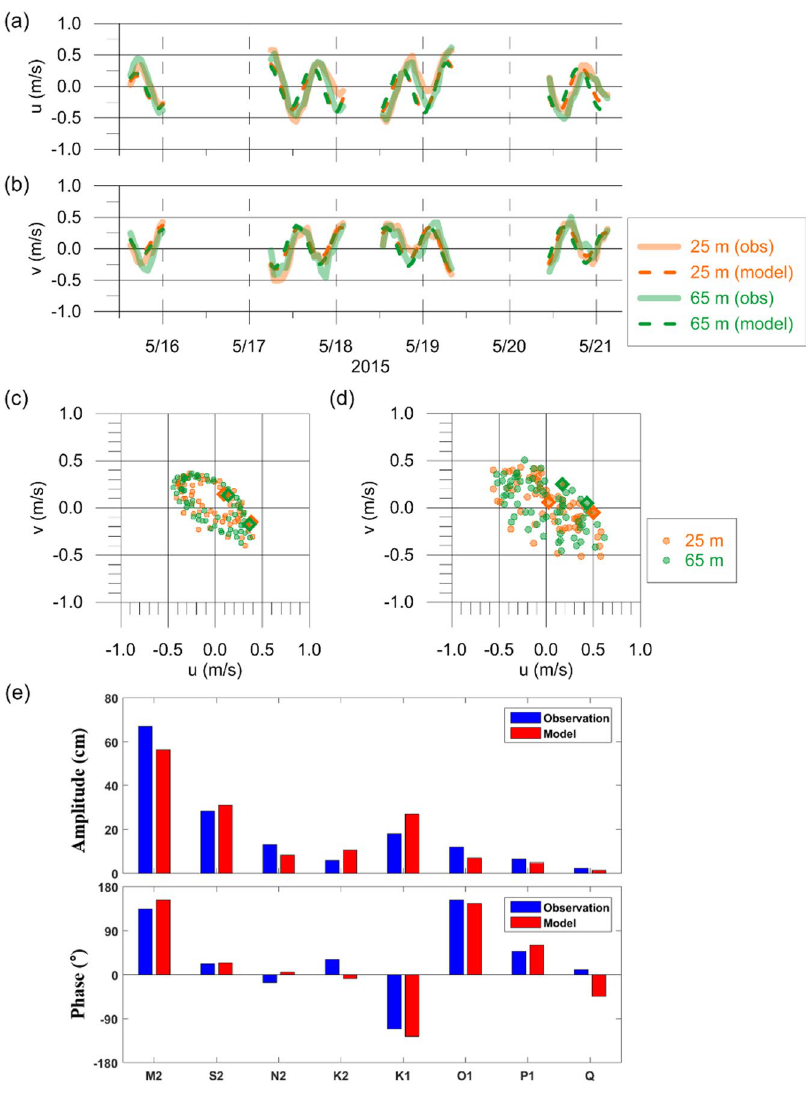
Figure 2. Time series of ( a ) zonal and ( b ) meridional components and ( c , d ) hodographs of absolute (mostly tidal) horizontal current vectors at the upper (25 m, orange) and lower (65 m, green) depths in the SAVEX-15 area (water depth: 100 m), ~50 km east of the IORS in May 2015. Time series of ( a ) zonal and ( b ) meridional components and ( c , d ) hodographs of absolute (tidal plus subtidal) horizontal current vectors at the upper (25 m, orange) and lower (65 m, green) depths in the SAVEX-15 area (water depth: 100 m), ~50 km east of the IORS in May 2015. In ( a ) and ( b ), each component observed during the SAVEX-15 cruise (thick solid line) and reproduced by the ROMS (dashed line) are superimposed. The reproduced and observed horizontal current vectors are shown by circles with an interval of one hour in ( c ) and ( d ), respectively. Open diamond symbols denote a time difference of 48.00 hours to compare the relative phase of tidal currents over the period shown in ( a ) and ( b ). The model data during the observational gap period caused by acoustic experiments (when the ADCP turned off) were not used here. In ( e ), shown are the tidal amplitudes and phases of for 8 major tidal constituents reproduced by the ROMS (red) and observed at the IORS (blue) for the period from April to June